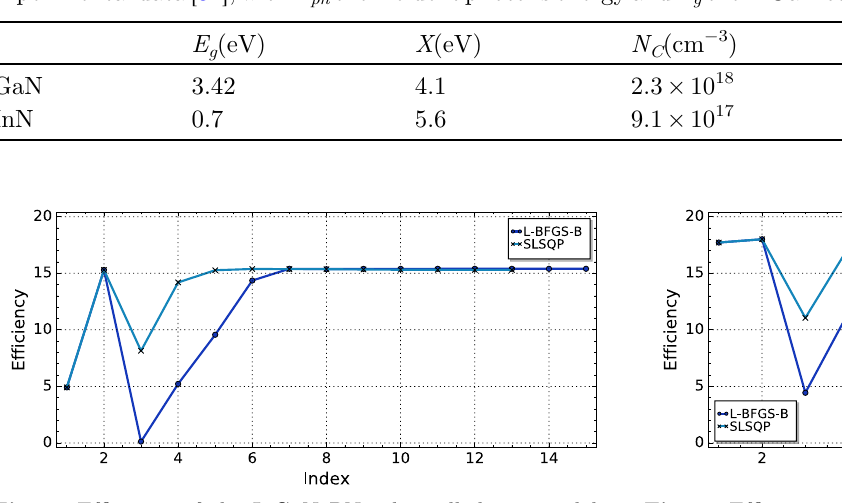
Fig. 5. Ef fi ciency of the InGaN PN solar cell determined by SLALOM using the L-BFGS-B and SLSQP methods, with the initial point choosen in the close vicinity of the global